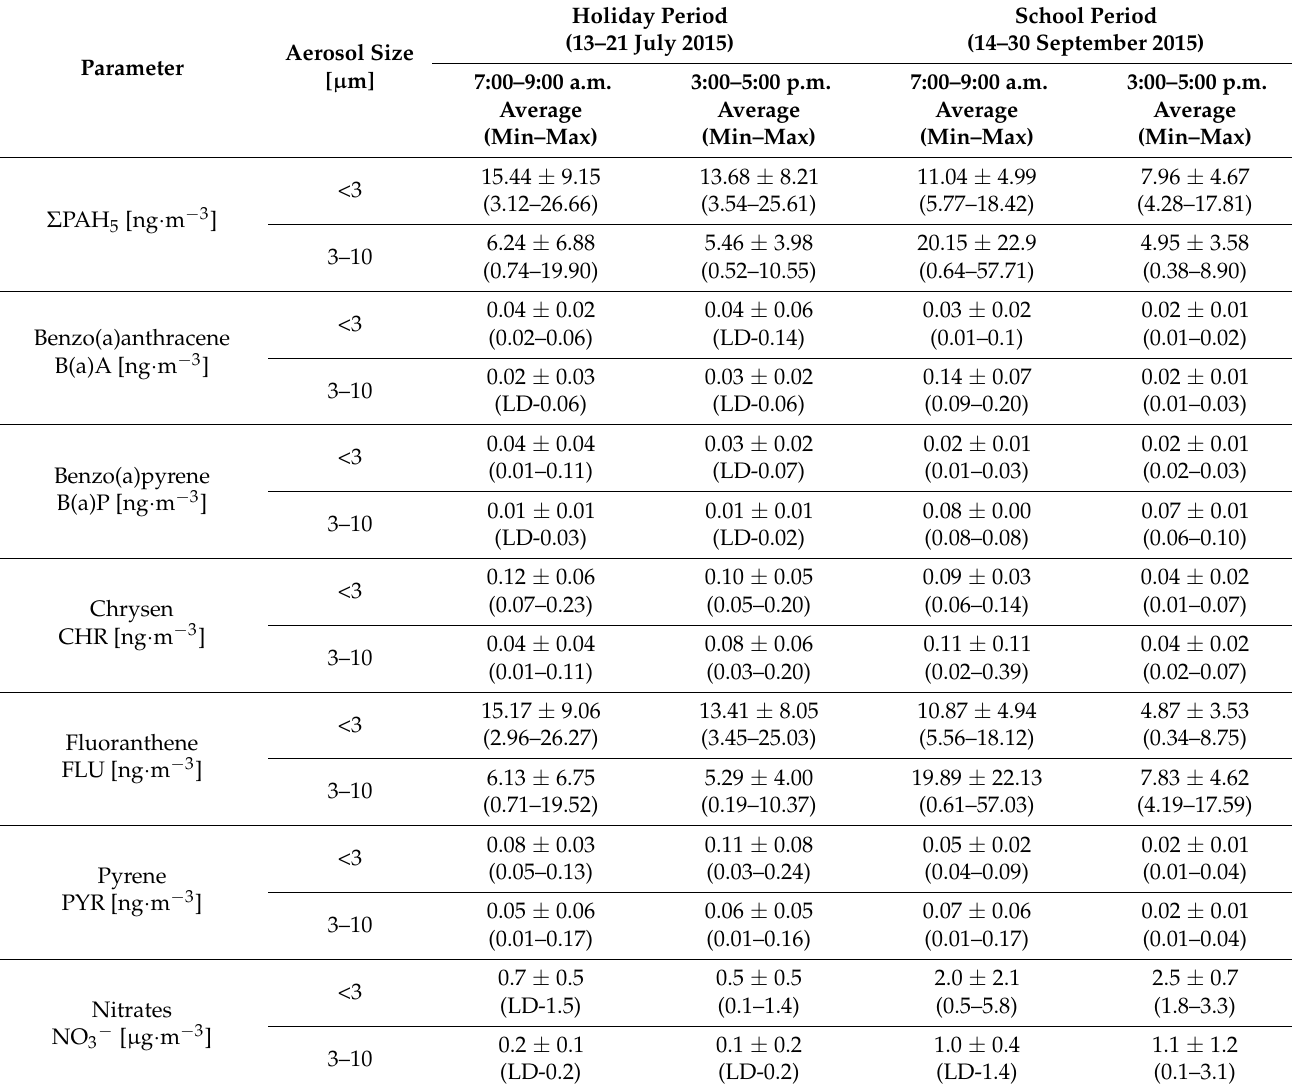
Table 2. Statistical characteristics of PAHs, OC, and EC concentrations and selected ionic aerosol components during the morning and afternoon traffic peak during school and holiday periods.